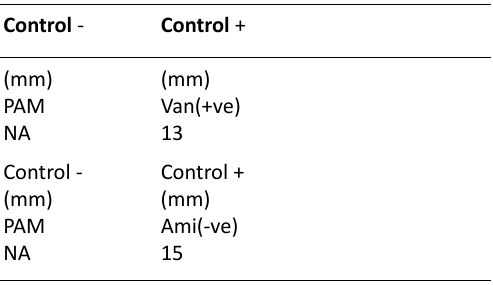
table 2. Zone inhibitions of positive control (amikacin or vancomycin) against S. aureus and E. coli